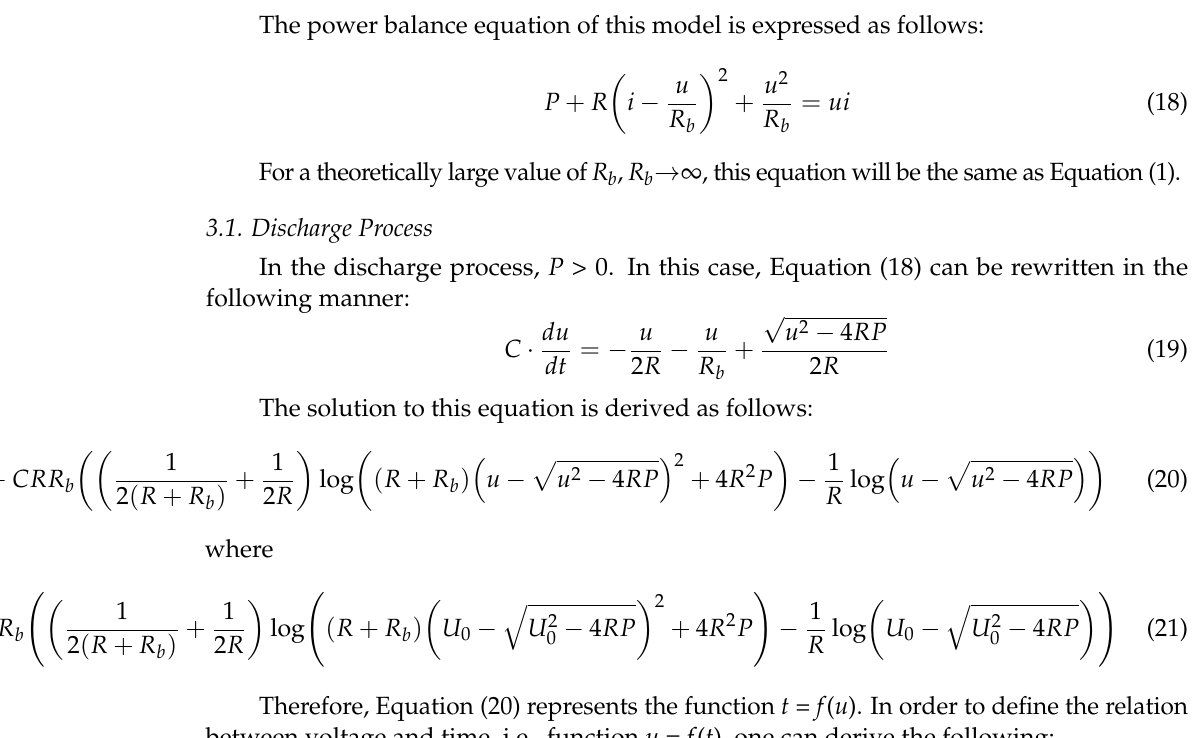
Figure 2. Discharging of a SC at constant power P , considering the leakage current.